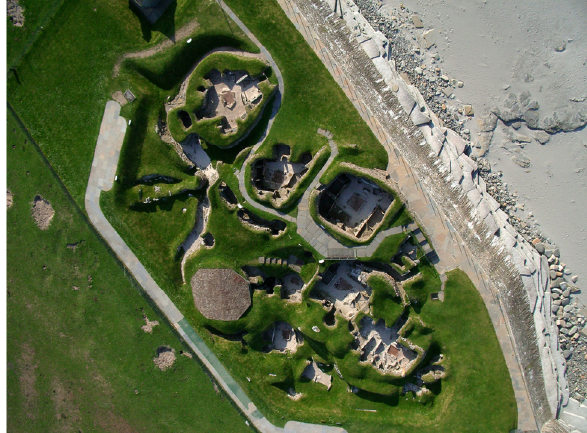
Figure 1. Aerial photo of Skara Brae, showing close network of houses and proximity of site to coastline © P. and M. Snodin